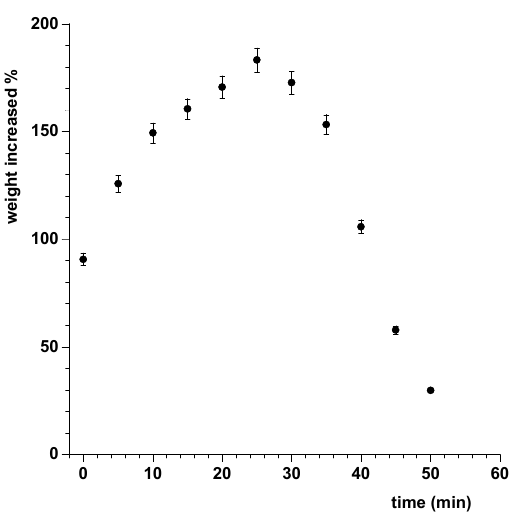
Figure 5. Swelling index measured as percent of weight increased vs. time. Values are presented as means ± SD ( n = 6).